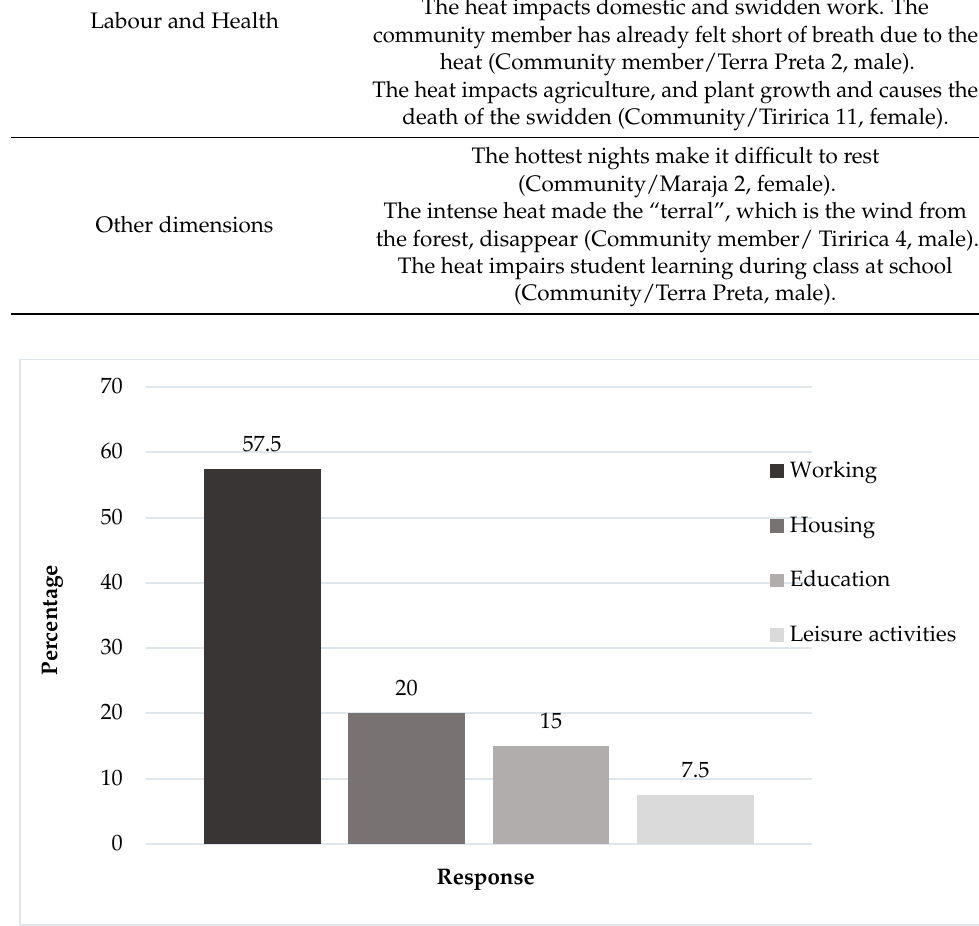
Figure 11. Community adaptations in the face of hydroclimatic changes.